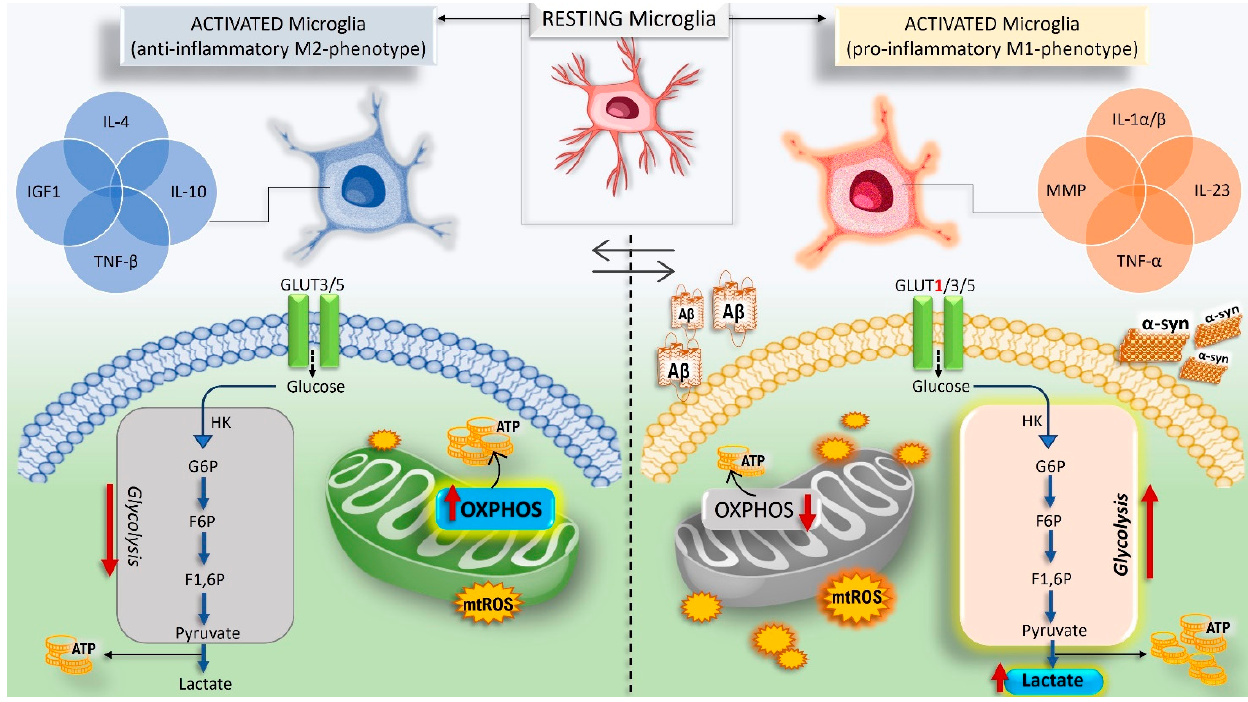
Figure 2. Schematic representation of microglial polarization, metabolic reprogramming, and im- mune responses under physiological and neuropathological conditions. In response to different en- vironmental and cellular stresses, microglia promptly activate pro- or anti-inflammatory states to preserve tissue homeostasis. In addition to changes in morphology, phagocytosis capacity, and se- cretion of cytokines, activation of microglia results in changes in cellular energy demand. Under neuropathological conditions (e.g., Parkinson’s disease (PD) and Alzheimer’s disease (AD)), pro- inflammatory microglial activation (M1-like) requires metabolic shifts towards glucose uptake and glycolysis, with the consequent expression of glucose transporter 1 (GLUT1), as well as the produc- tion of lactate and reactive species. Conversely, under physiological and anti-inflammatory condi- tions, microglia (M2-like) mostly rely on oxidative phosphorylation.